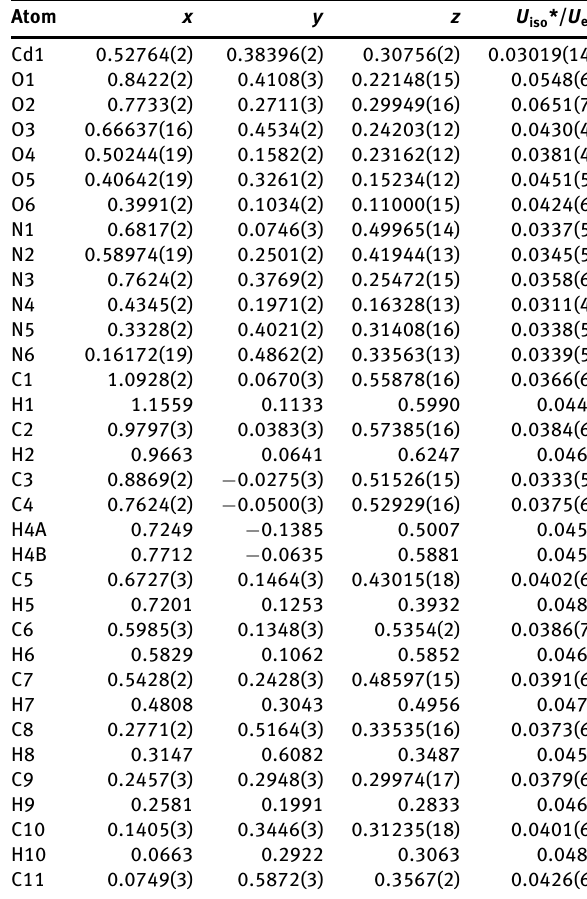
Table 2: Fractional atomic coordinates and isotropic or equivalent isotropic displacement parameters (Å 2